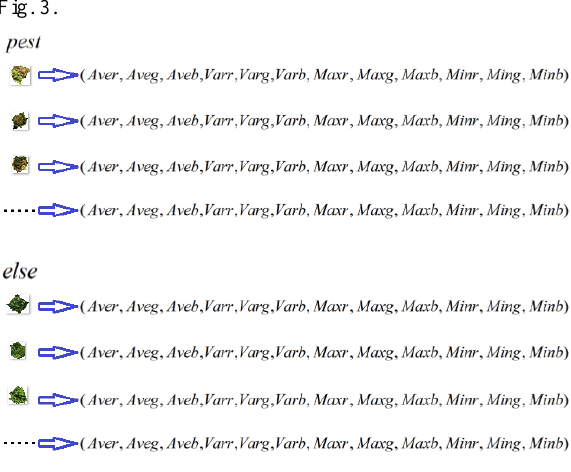
Figure 3. Extraction of feature As in Figure.